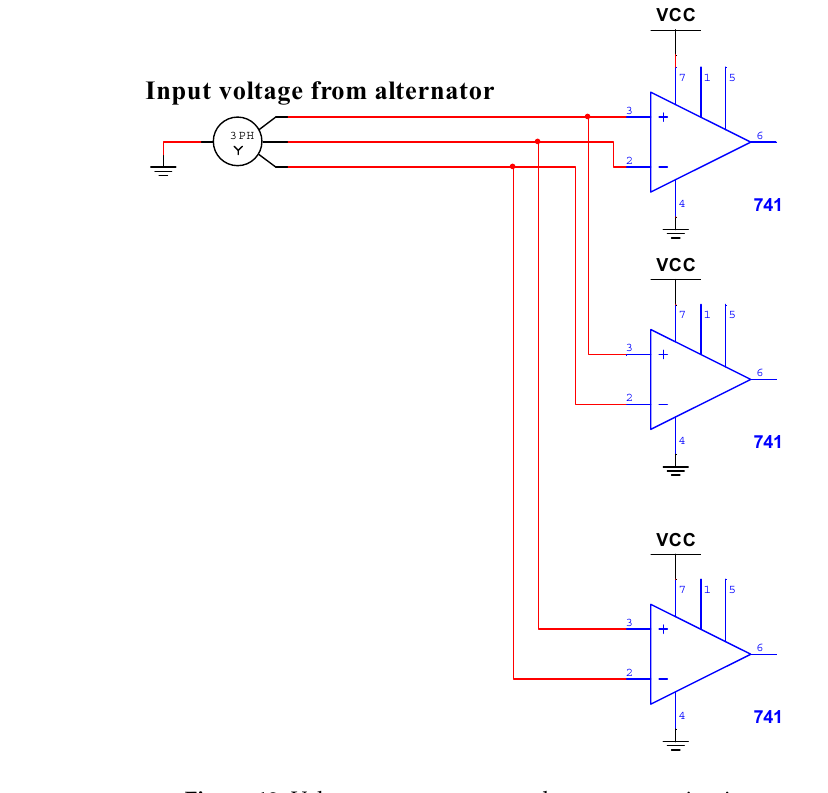
Figure 10. Voltage measurement and comparator circuit.